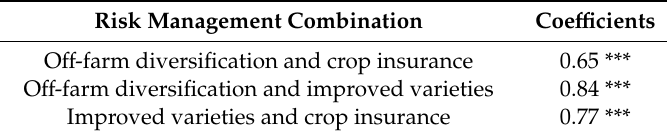
Table 1. Correlation coe ffi cients of risk management